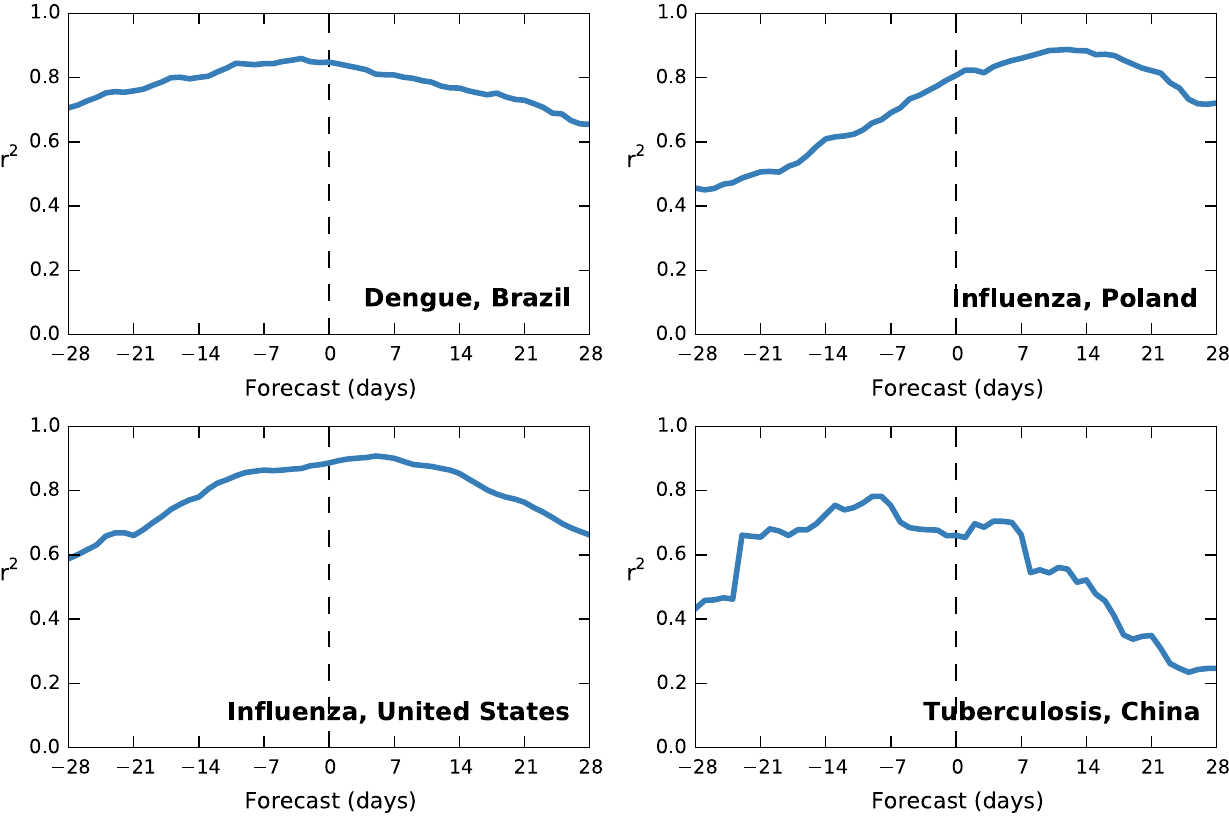
Figure 2. Forecasting effectiveness for selected successful models. This figure shows model r 2 compared to temporal offset in days: positive offsets are forecasting, zero is nowcasting (marked with a dotted line), and negative offsets are anti-forecasting. As above, figures for the four successful contexts not included here are in the supplemental data S1.